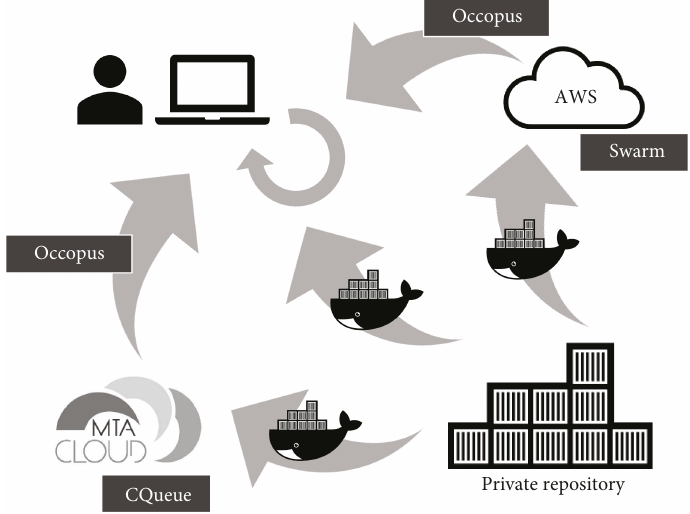
Figure 1: Docker@SZTAKI: main components with their typical usage scenarios.